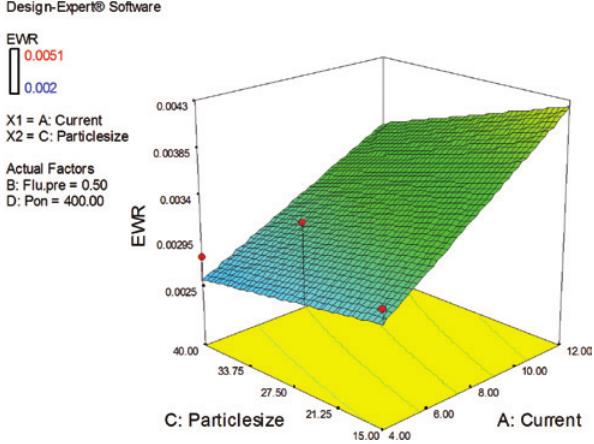
Figure 7 Interactive effect of current and particle size on